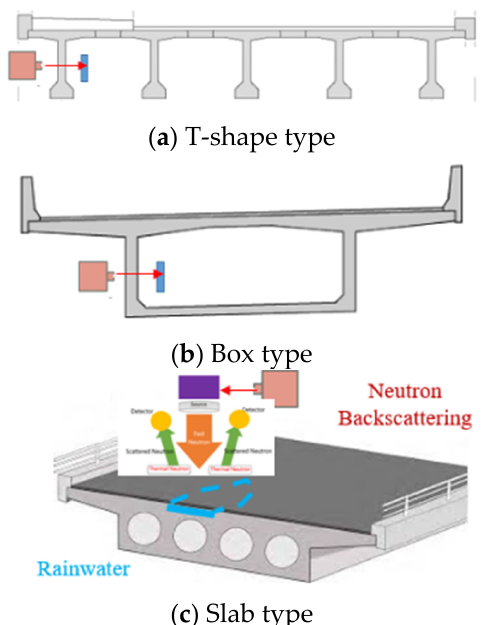
Figure 4. Types of PC bridges. ( a ) T-shape girder type; ( b ) box-shape girder type; ( c ) Slab type.